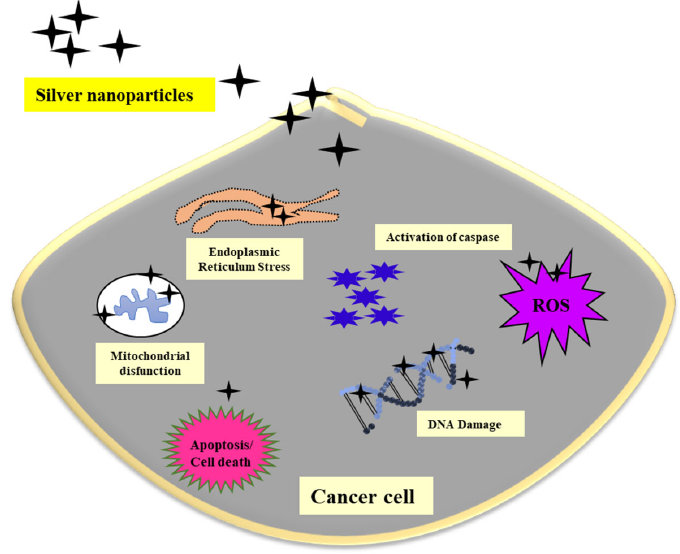
Figure 7. Schematic illustration of the possible mechanism of AgNPs acting on cancer cells. Table 3. List of natural plant–synthesized AgNPs used against different cancer cells.